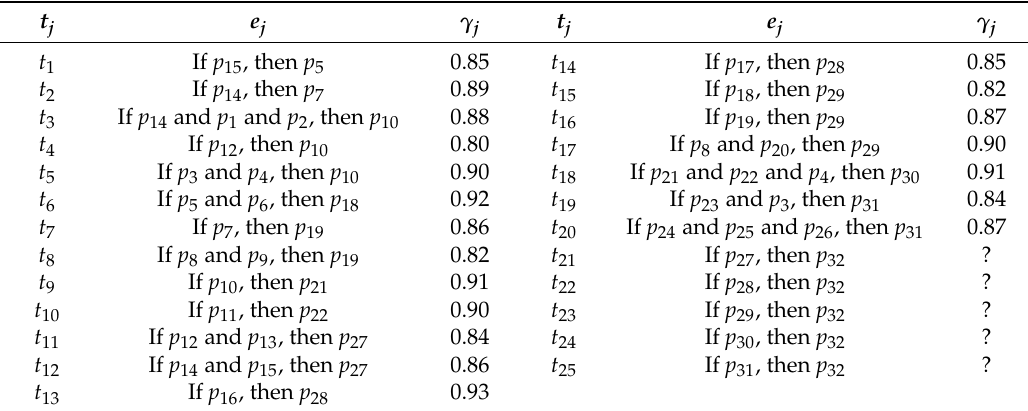
Table 3. t j , e j and γ j of the FRPN for the CNC machine tool.